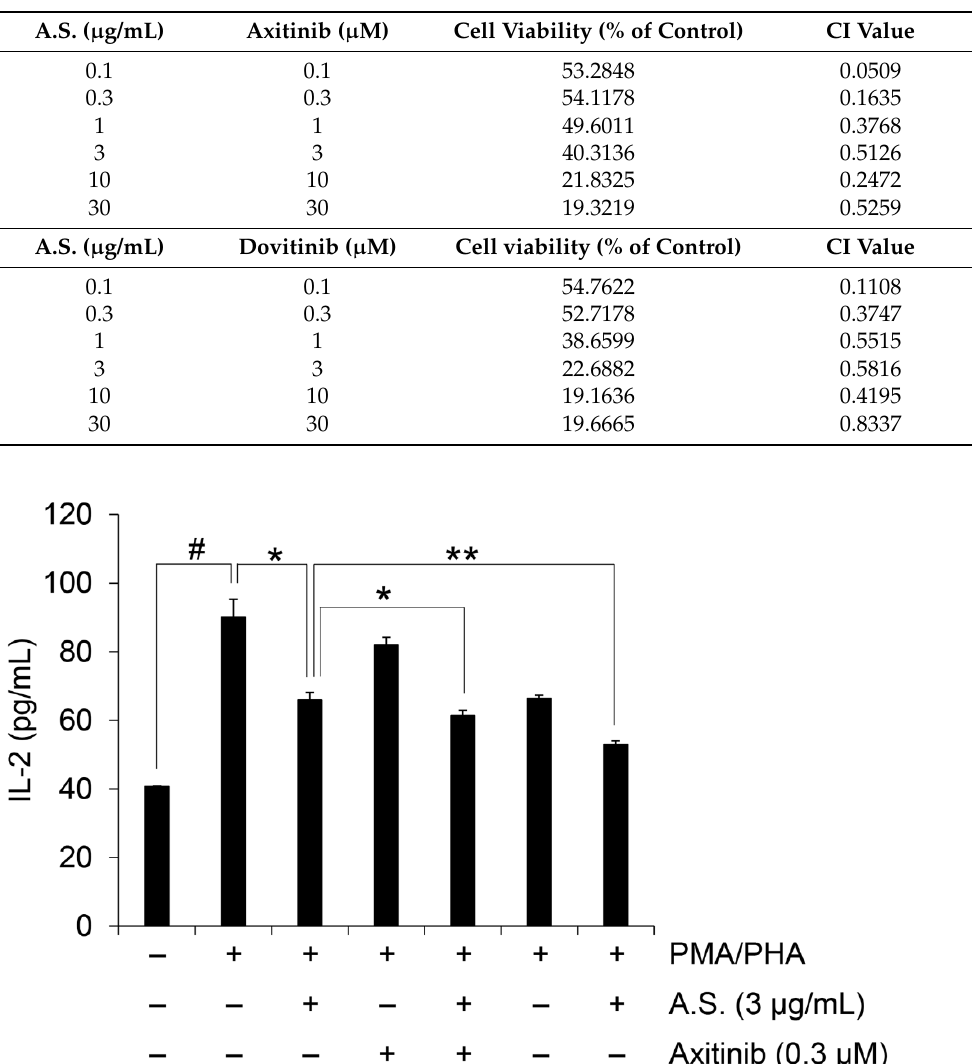
Table 1. Combination index (CI) values for the combination of A.S. and axitinib/dovitinib against Jurkat cells viability.